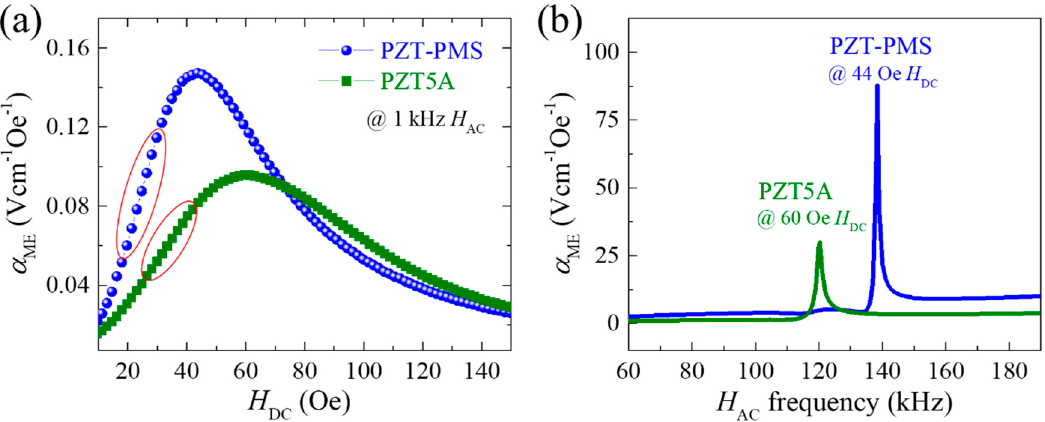
Figure 3. ( a ) Magnetoelectric voltage coefficient of PZT-PMS and PZT5A sensors measured at 1 kHz as a function of H DC . ( b ) Magnetoelectric voltage coefficient spectra of PZT-PMS and PZT5A sensors as a function of H AC frequency. (FE dimensions: 13.5 mm ( l ) × 3.0 mm ( w ) × 1.0 mm ( t )).